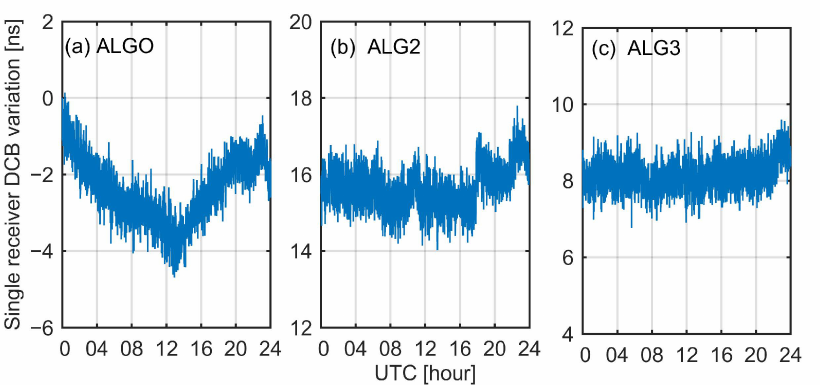
Figure 5. Epoch-by-epoch estimates of single-receiver DCBs retrieved with the MCCL plus datum method for three co-located receivers: ALGO, ALG2, ALG3 on DOY 07, 2017.